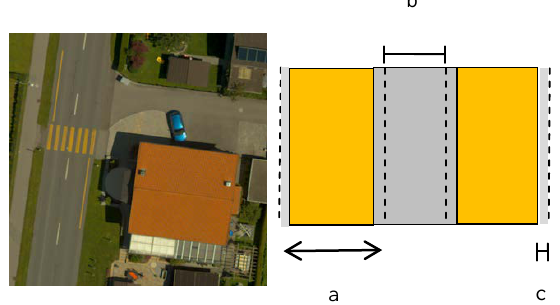
Figure 5. Stripes on roads at different image parts may be used to check for blooming and PRNU Tests with the RCD30 camera showed satisfying results (cf. Ta- ble 4). The measured intensity values are equal in the middle and the edge of the image; the differences between the stripes and spaces were 2.6 and 2.2 pixels respectively. The displace- ment (c) is only a quarter of these values. At images with GSD=5 cm the edge of a stripe is then shifted by about 3 cm.